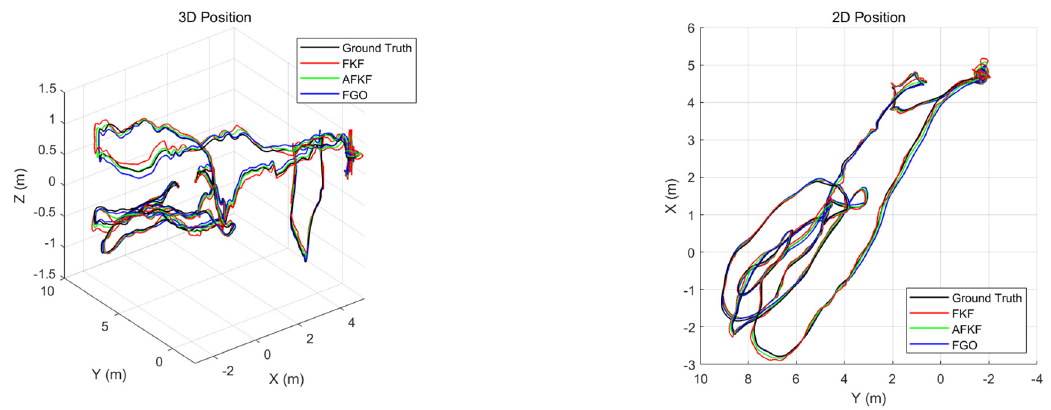
Figure 13. Comparison of 3D position and 2D position of different algorithms in MH_01_easy scene. The 3D position and 2D position trajectories of the MH_01_easy scene are shown in Figure 13. Compared with AFKF and FKF, FGO is closer to the real trajectory, and has a